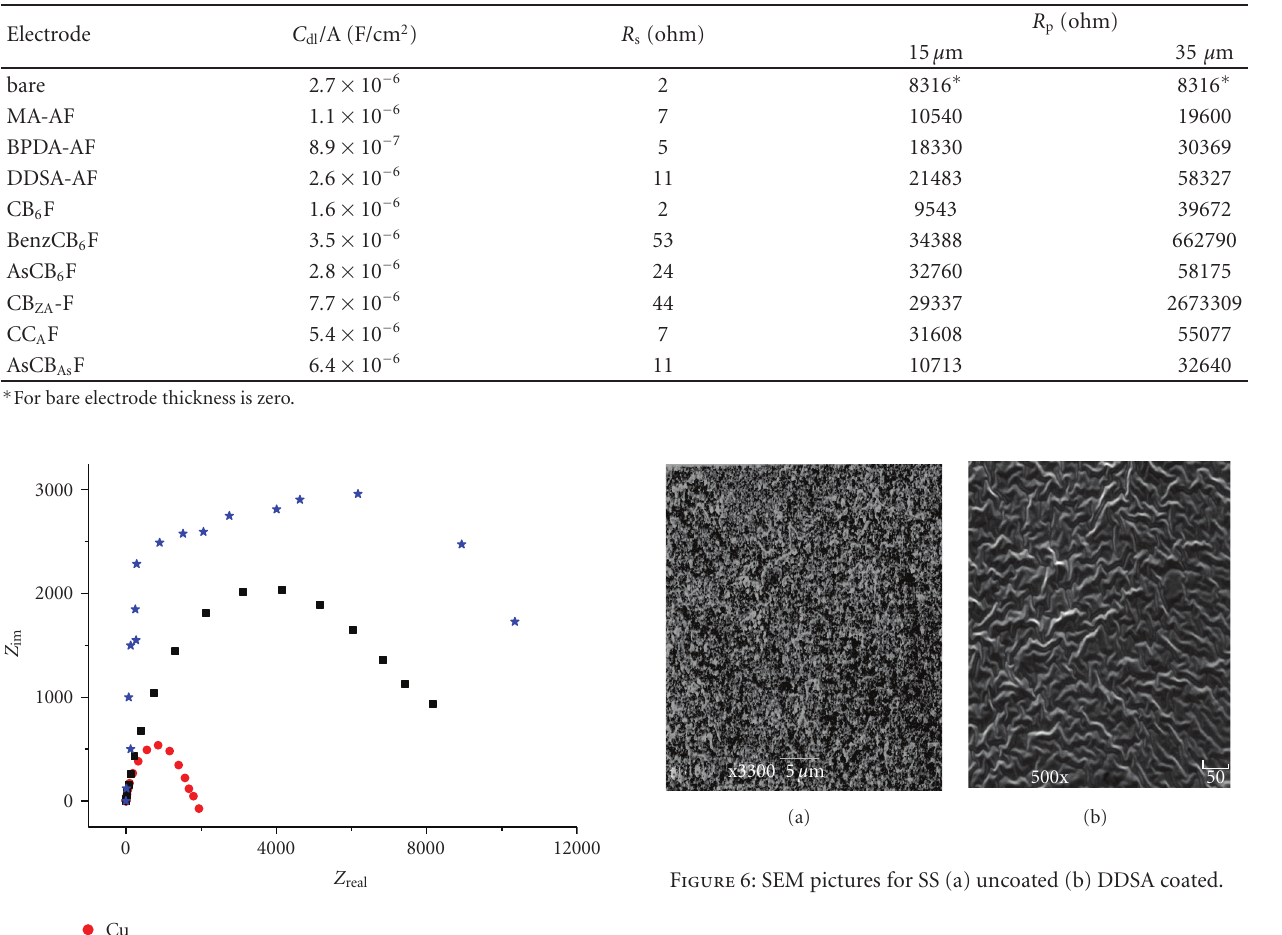
Table 2: Impedance values for bare and coated copper.